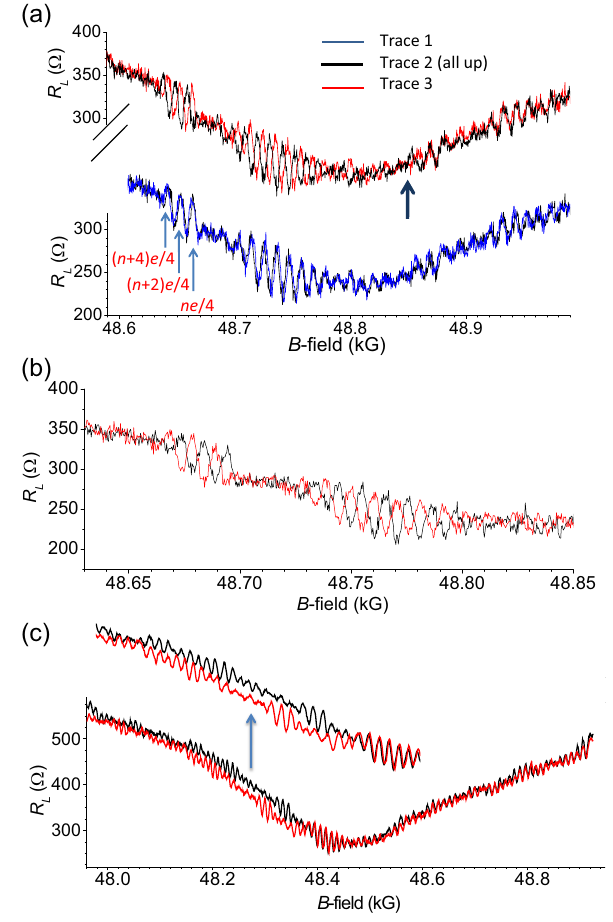
FIG. 9. π phase shifts in high-frequency oscillations at ν ¼ 7 = 2 : (a) three consecutive magnetic field upsweeps taken near ν ¼ 7 = 2 as in Fig. 7 from the same sample but of a different preparation (sample 6, preparation 19, device type b, T ∼ 20 mK). Traces 1 and 2 [bottom of panel (a)] overlap, whereas in trace 3 [top of panel (a) shown alongside trace 2 repeated for comparison] a π phase jump occurs in the time intervening trace 2 and 3 as this phase difference is apparent from the lowest shown B -field up to about 48.85 kG (marked by an arrow), at which point the phase reverts to that of trace 2. (See also Supplemental Material Sec. S5d [34].) (b) Two downsweeps [same sample and prepa- ration, sweeps separated by days from (a)]. The two traces of R oscillations are out of phase by π . The π phase jump seemingly occurs away from the depicted oscillations showing the full extent of the sweep. (c) Consecutive downsweeps from the same sample and preparation [hours apart between the sweeps but days prior to the sweeps in panels (a) and